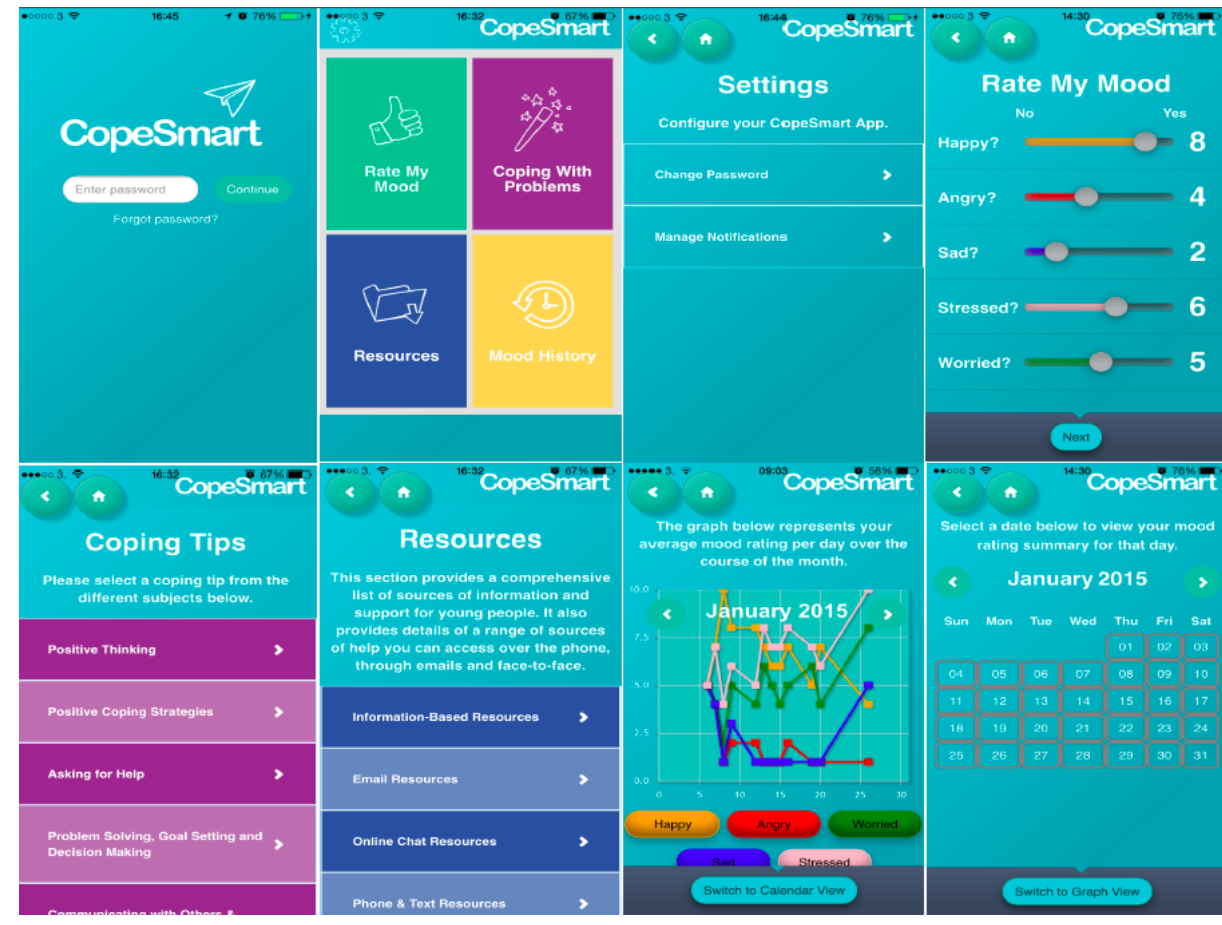
Figure 1. CopeSmart app